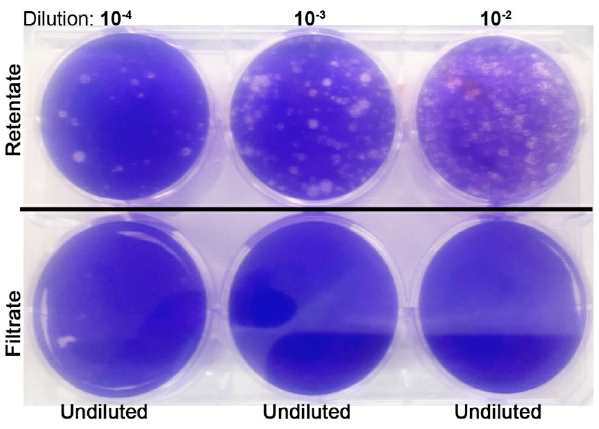
Figure 1. Representative image of plaque-forming units (PFU) assay performed on the retentate (top panel) and undiluted filtrate (bottom panel) of samples passed through 3 kDa molecular weight cut-off (MWCO) ultrafiltration unit. Note the viral plaques (white dots) only in the retentate.